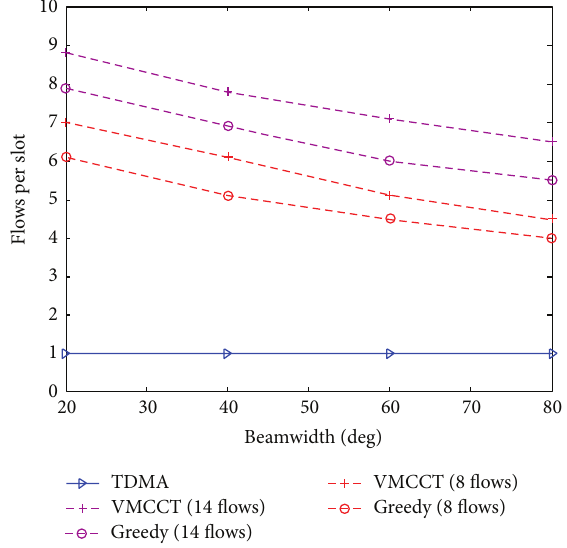
Figure 8: Improved average flows throughput versus flow density. Figure 9: Improved average flow throughput versus increasing